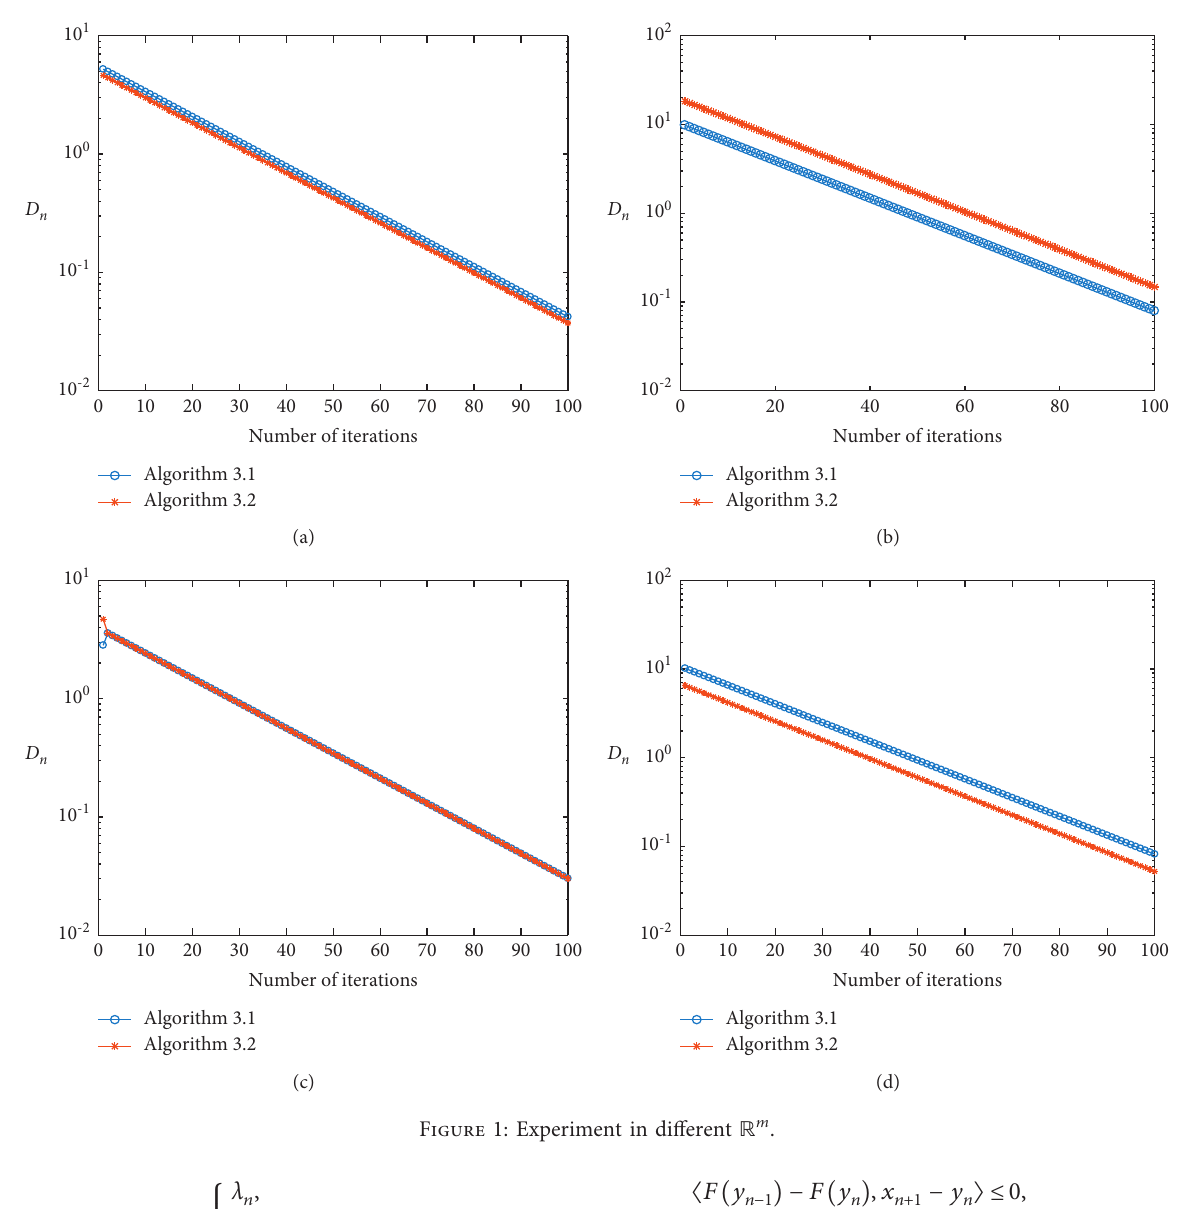
Figure 1: Experiment in different R m